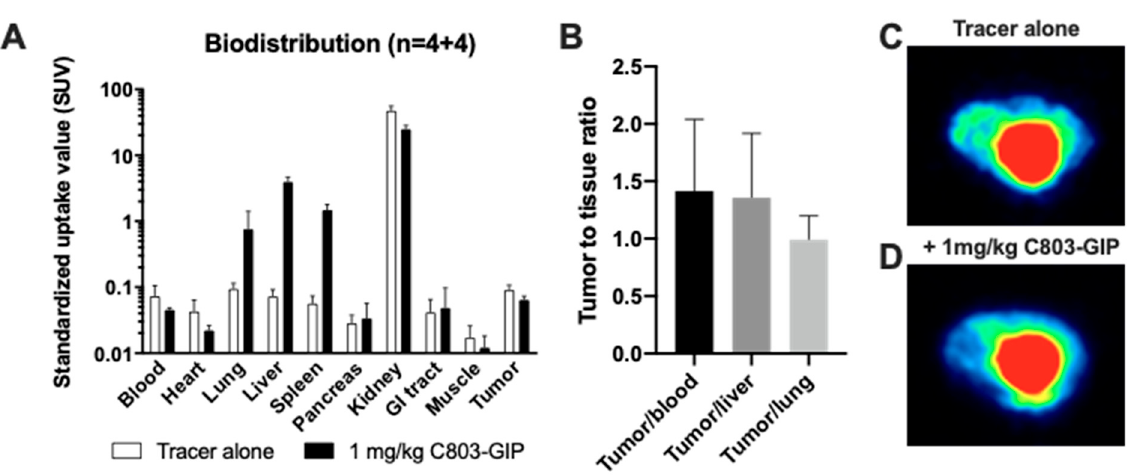
Figure 6. ( A ) In vivo biodistribution in mice carrying a GIPR-expressing xenograft tumor. ( B ) Tumor-to-tissue background ratios for some tissues with potential NEN metastasis. Representative PET images (transaxial projections) showing the binding of [ 68 Ga]Ga-C803-GIP in xenograft tumor alone ( C ) or challenged by unlabeled C803-GIP ( D ). White arrows indicate the location of the tumor, and red arrows indicate the bladder.